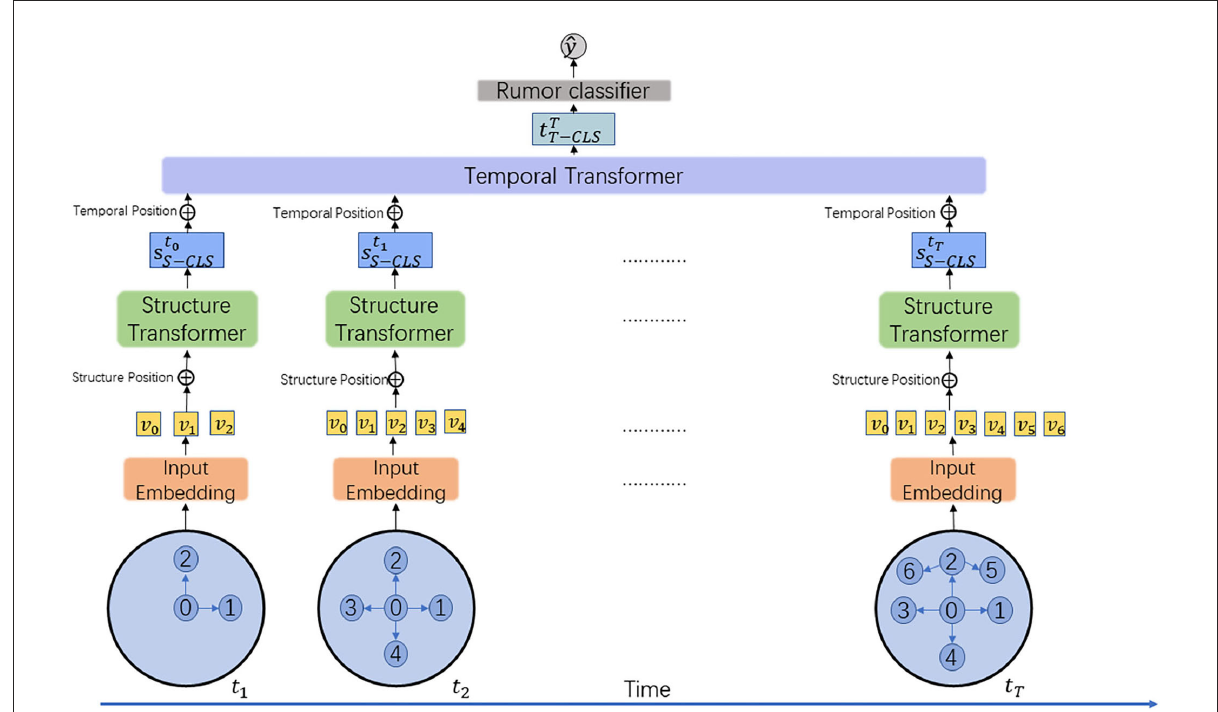
FIGURE2 The proposed DGTR model. The bottom part of the figure shows the dynamic diagram of news dissemination. The orange part is the input embedding layer; the green part is the structural transformer layer; the purple part is the temporal transformer layer; and the gray part is the rumor classification